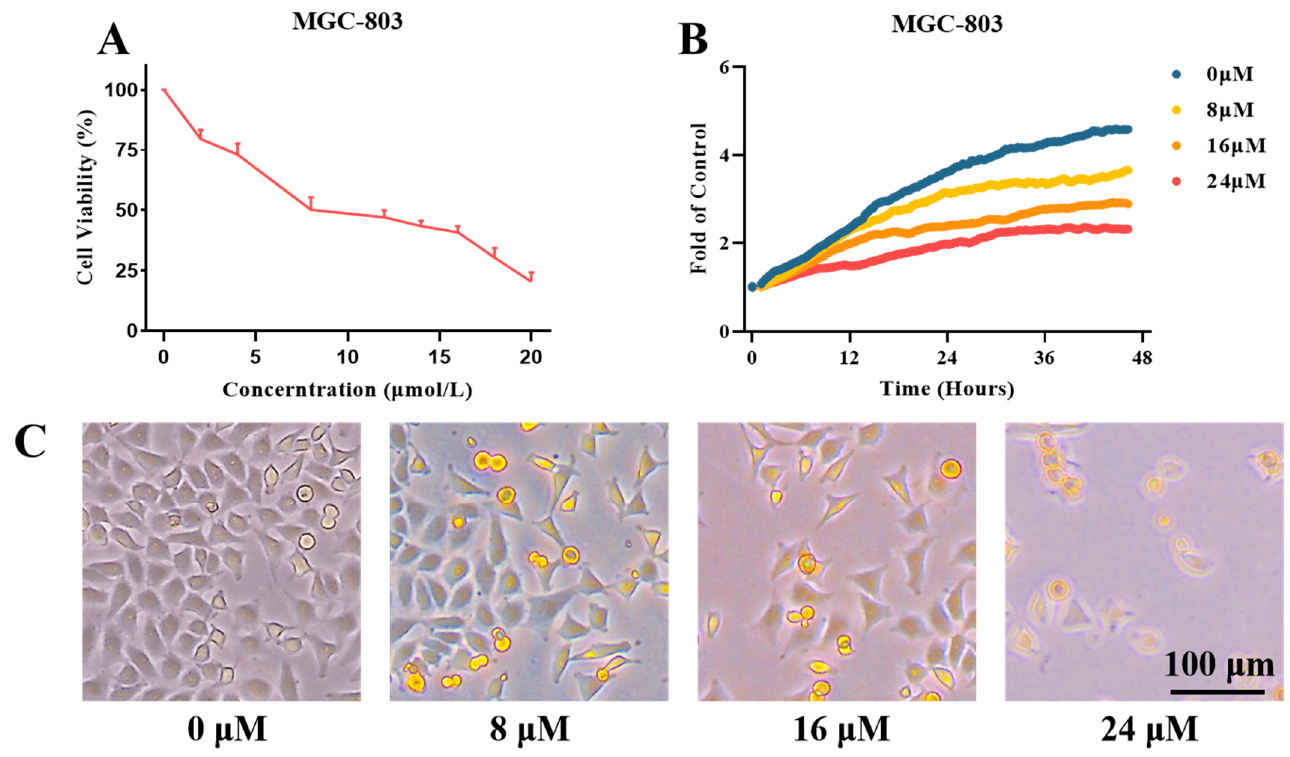
Figure 4. Effects of compound H12 on MGC-803 cells. MGC-803 cells were treated with indicated concentrations of compound H12 for 48 h. ( A ) Cell viability of MGC-803 cells after treatment with DMSO or compound H12 . The experiment was repeated three times independently. ( B ) Cell growth curves of MGC-803 cells after treatment with DMSO or compound H12 . ( C ) The morphological changes of MGC-803 cells after treatment with DMSO or compound H12 .